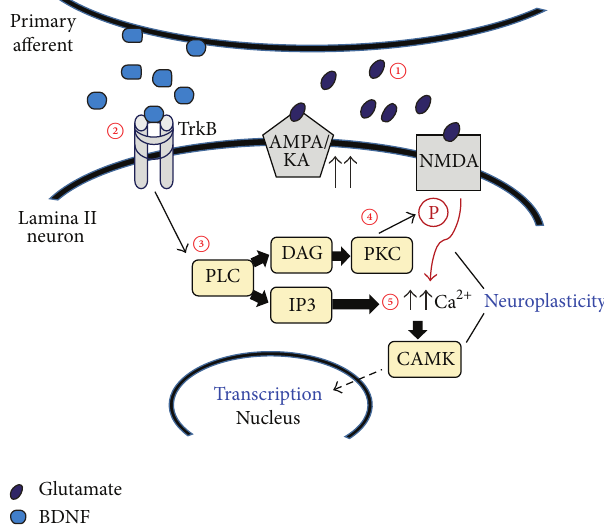
Figure 3: Proposed mechanism of BDNF-induced synaptic facil- itation. Small diameter primary afferents express glutamate and BDNF. A Under normal conditions, dorsal root stimulation evokes stable glutamatergic synaptic responses in lamina II neurons. B Increased excitability of primary afferents causes the release of both glutamate and BDNF, which binds to TrkB receptors. Engagement of the TrkB receptors recruits the C PLC which can lead to activation of D PKC and E an increase in intracellular calcium [ Ca 2+ ] i . Both PKC and calcium dependent kinases such as CAMK can phosphorylate glutamatergic receptors, thereby increasing their calcium permeability. Consequently, these processes lead to an NMDA-R dependent facilitation of glutamatergic currents. Adapted from data reported in Garraway et al.